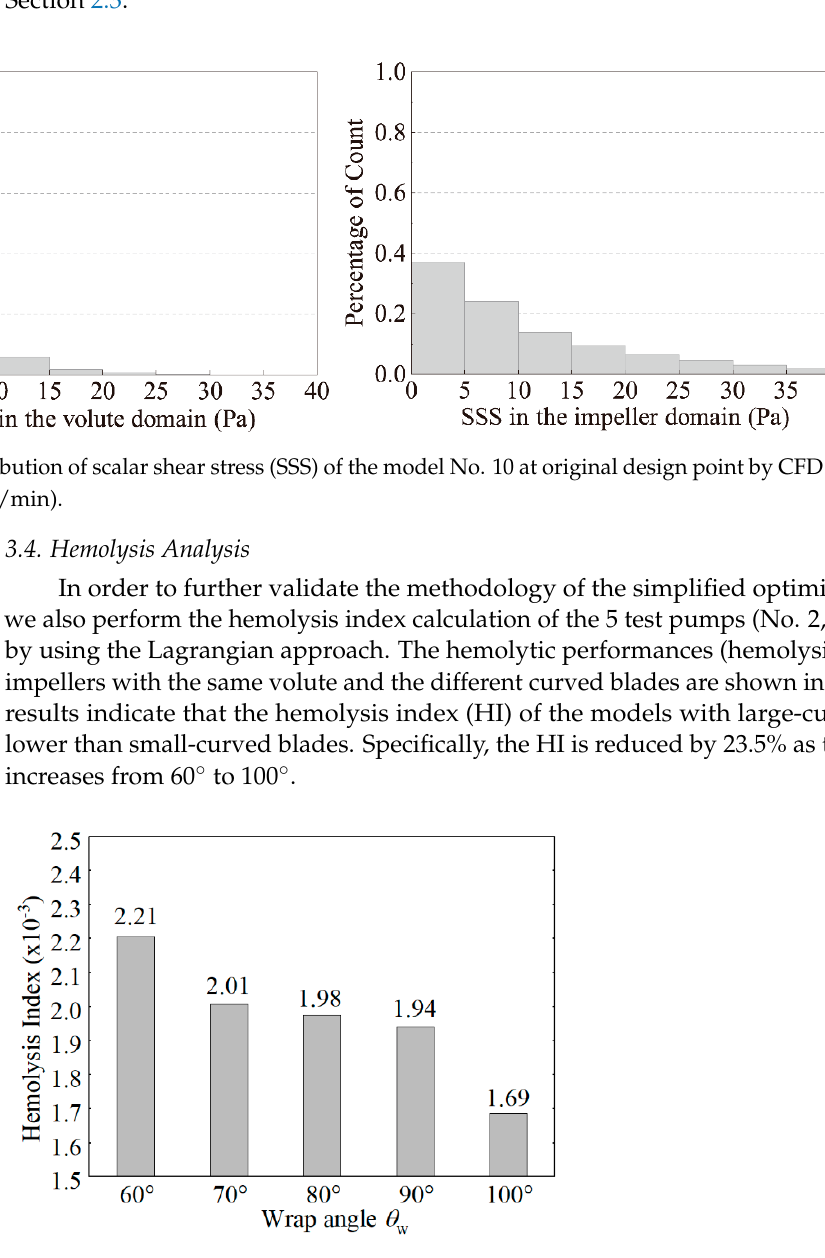
Figure 10. Maximum scalar shear stress (SSS) around the impeller area of six test pumps at the orig-